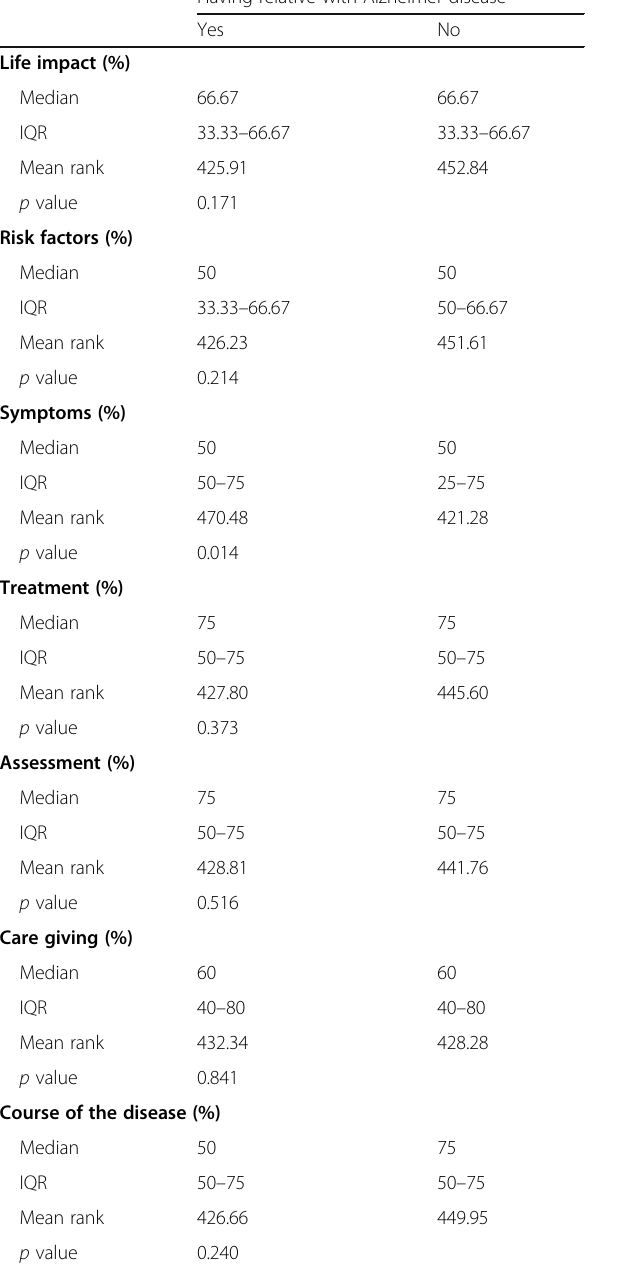
Table 8 Knowledge of different aspects of Alzheimer ’ s disease according to participant ’ s history of having relative with Alzheimer ’ s